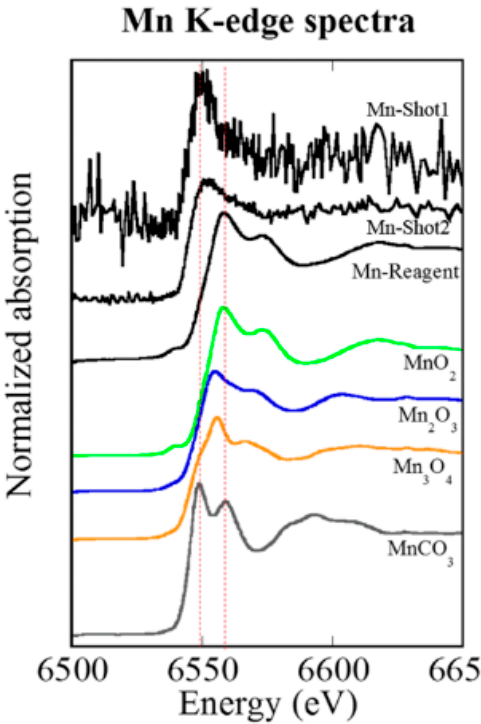
Figure 6. Mn K-edge XANES spectra (in Figure 5), located in the bronchiole cavity (Shot1) and located in the damaged tissue of the alveolus (Shot2), 6 h after 56 Mn(2 × ) internal exposure. The Mn K-edge XANES spectra both of Shot1 and Shot2 were different from that of Mn reagent and MnO 2, but similar to that of MnCO 3 solution. The red dotted lines indicate locations of peaks observed in MnCO 3 solution. The special similarities indicate that Mn is not in the Mn 4+ (Mn reagent, MnO 2 ), but is Mn 2+ (MnCO 3 ).